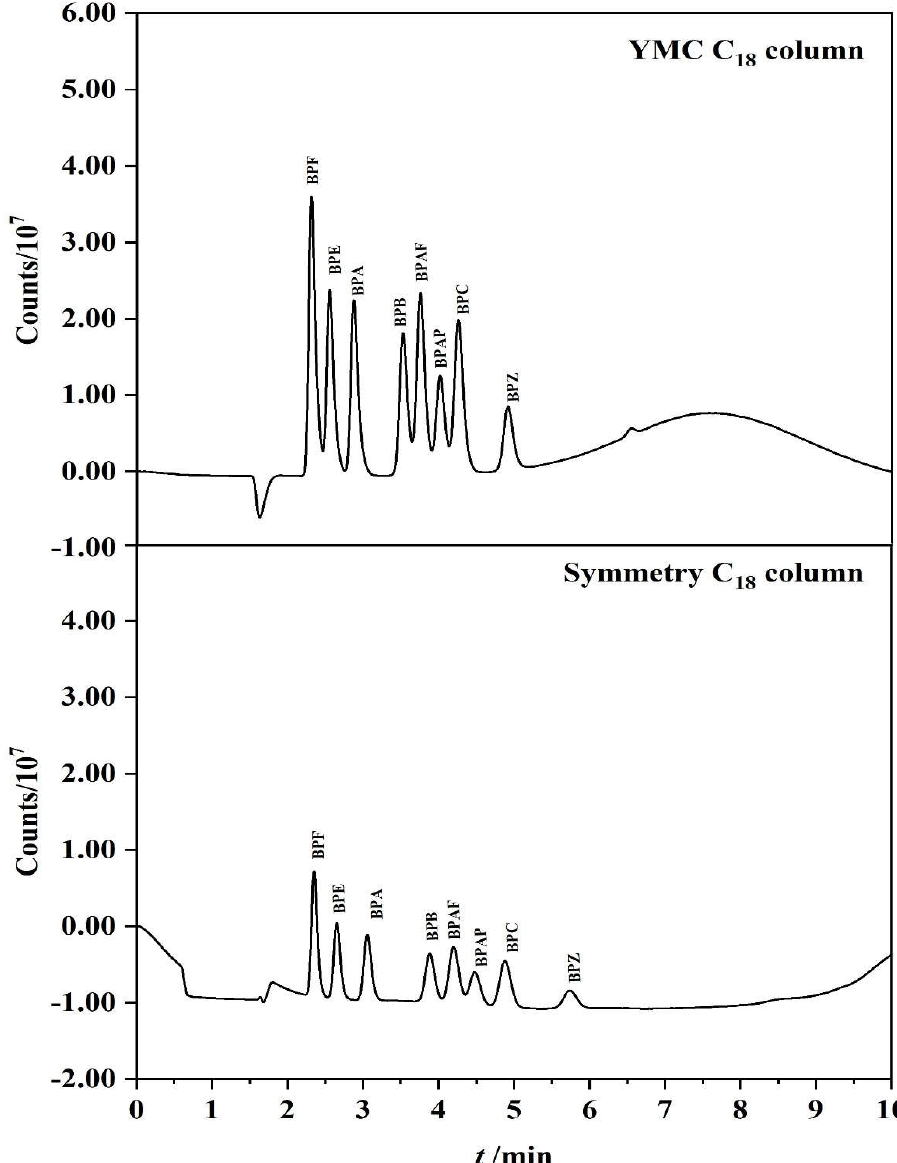
Figure 1. Comparison of separation and response of different chromatographic columns to the same BPs standard solution (YMC C 18 column vs. Symmetry C 18